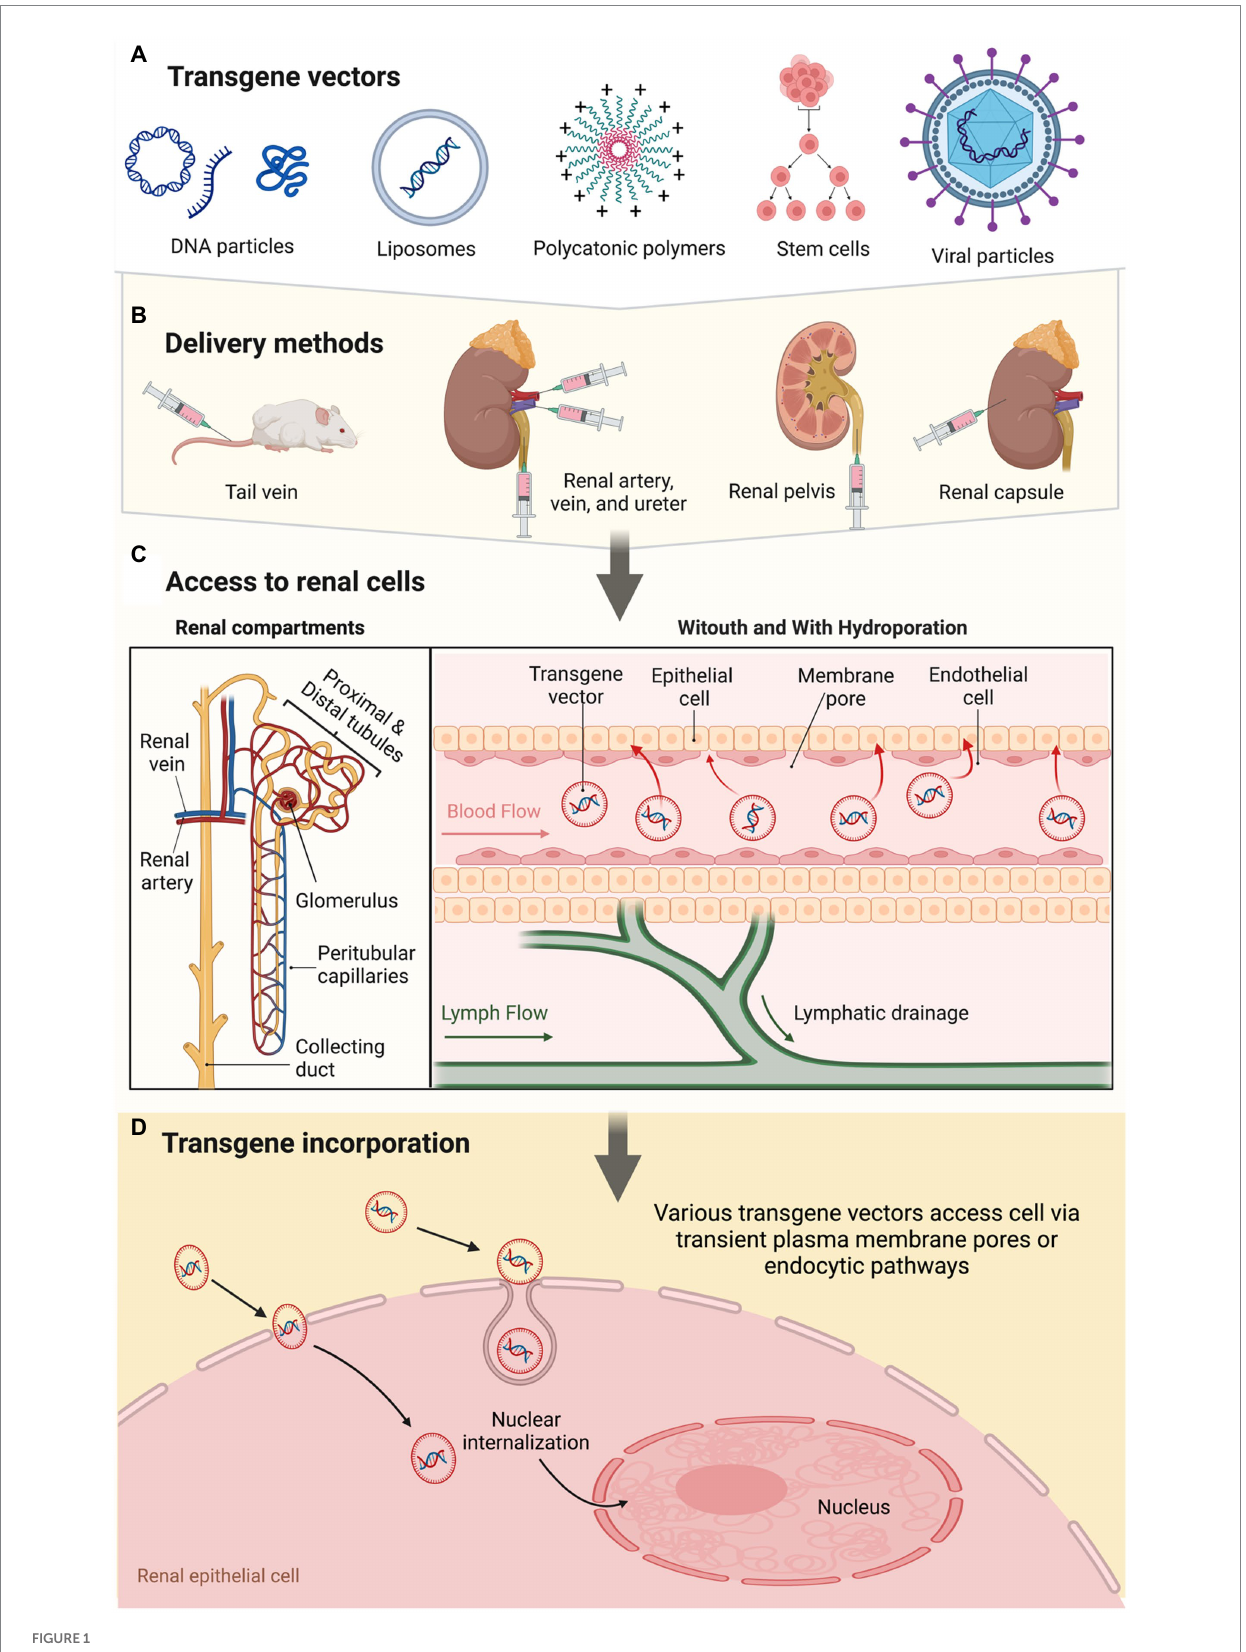
FIGURE 1 A schematic overview of the renal gene- and cell-based approaches highlights vectorization, delivery mode, and pathways supporting transgene incorporation and